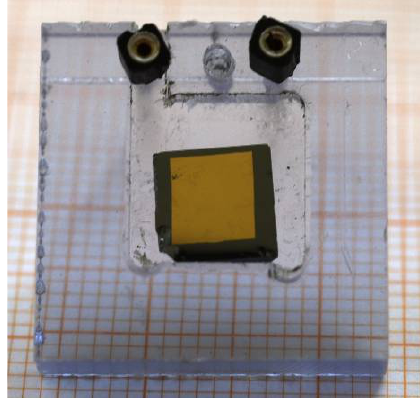
Figure 15 . CdZnTe planar detector, equipped with gold electrodes, deposited by electro- less technique. The crystal is grown by the boron oxide vertical Bridgman technique.